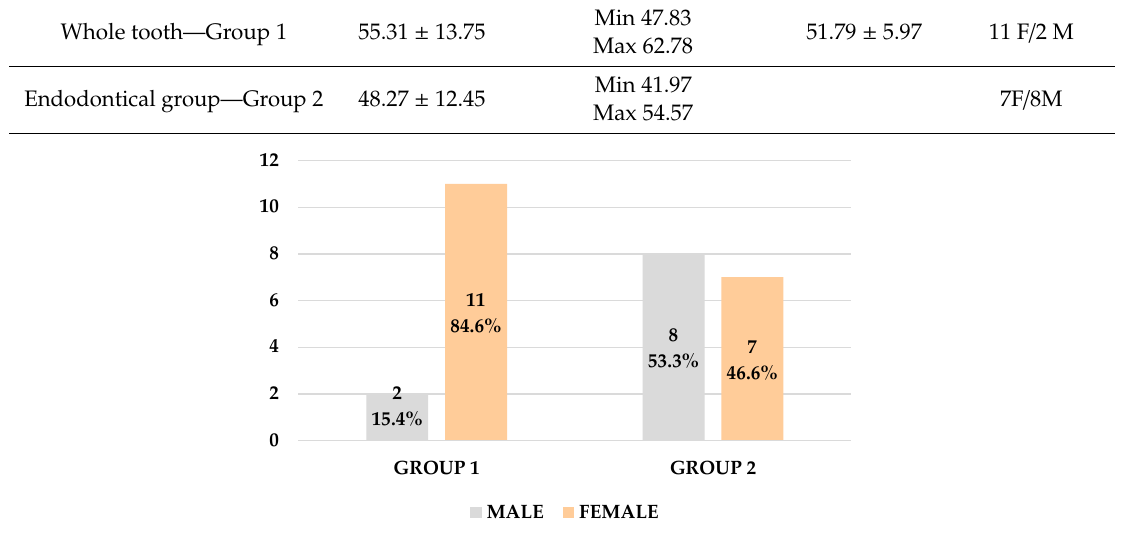
Table 2. Number of teeth per patient.